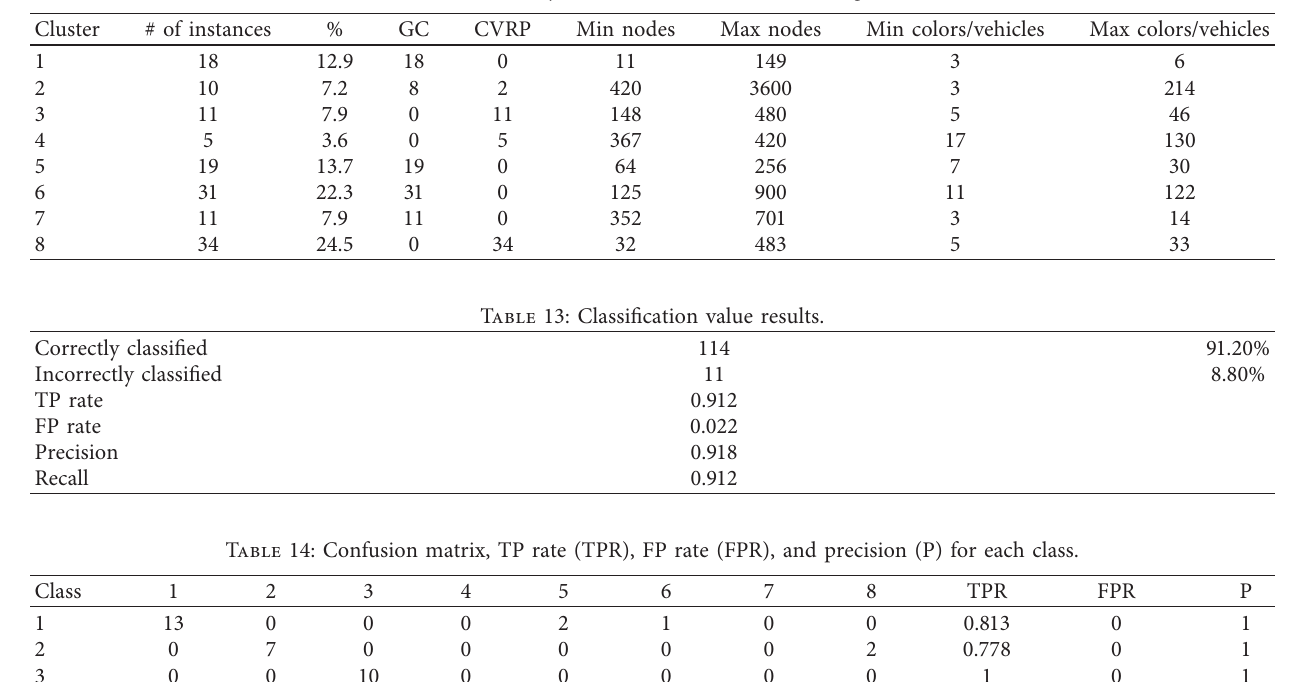
Table 12: Summary cluster/classes with k − means algorithm.